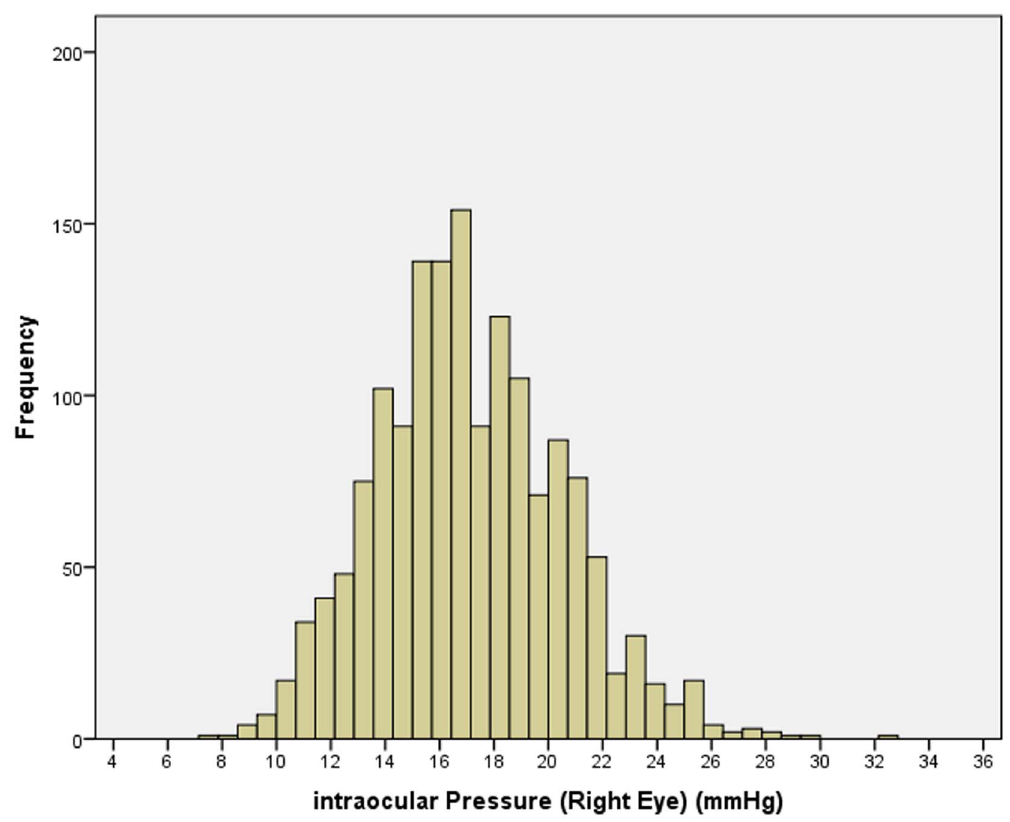
Figure 1. Histogram Showing the Distribution of Intraocular Pressure in the Gobi Desert Children Eye Study.